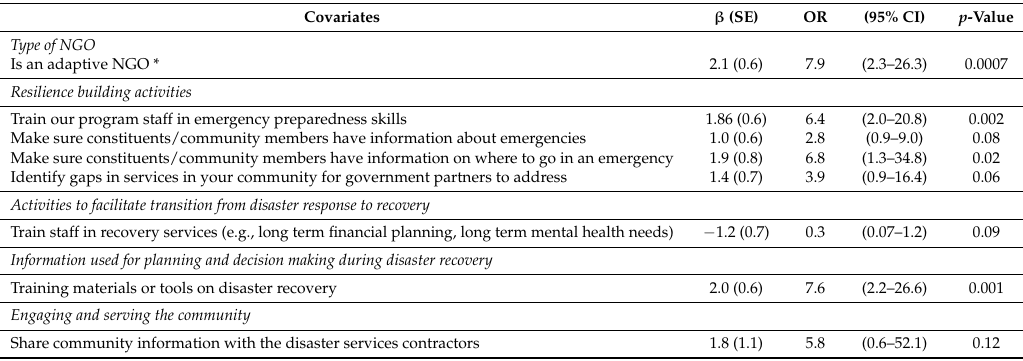
Table 3. Adjusted odds ratios (ORs) for NGO Type and NGO community activities associated with NGO routine participation in disaster